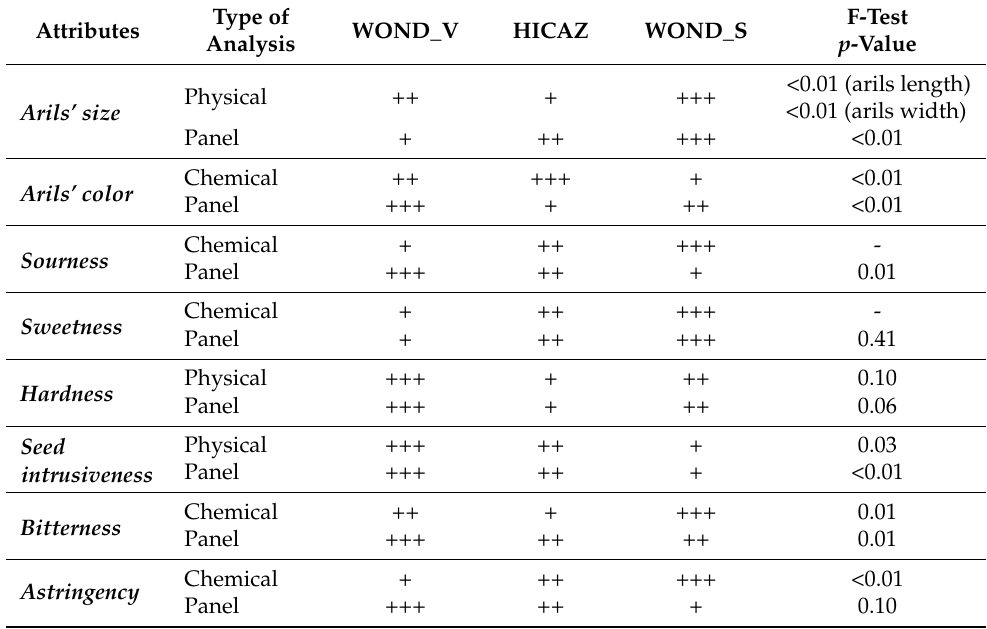
Table 2. Summary evaluation of sample characterization through chemical analysis and panel test